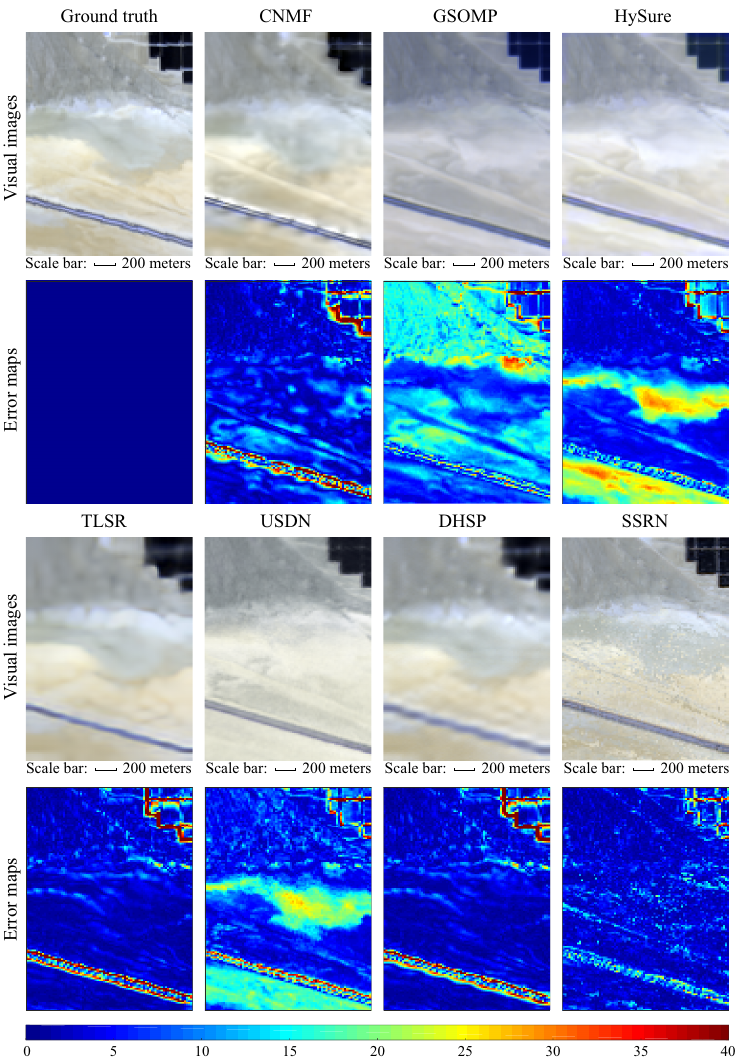
Figure 7. Visual images (R: 32, G: 20, and B: 8) and error maps of the proposed SSRN and the compared methods on the Ivanpah Playa